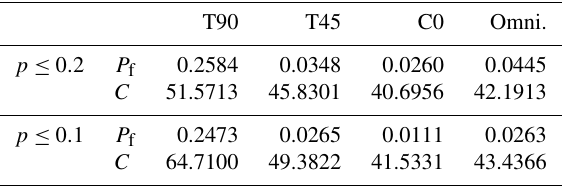
Table 5. Failure probabilities and cost function (Eq. 10) of